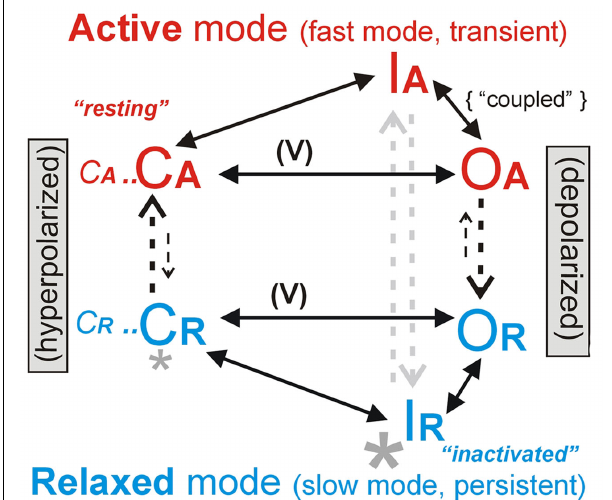
FIGURE 1 |Two major gating modes. A Nav channel has four voltage sensor domains and complex gating kinetics; this simplified scheme emphasizes voltage-dependent ( V ) activation [closed, open (C,O)], plus inactivation (I) to an open-like but occluded state in each of the two major modes (Active and Relaxed).The smaller letters (CA ... and CR ... ) serve as a reminder that a full kinetic scheme (e.g.,Taddese and Bean, 2002; Lenkey et al., 2011) would have many more states. Structural changes underlying mode switching, a feature of all voltage-gated proteins, are not